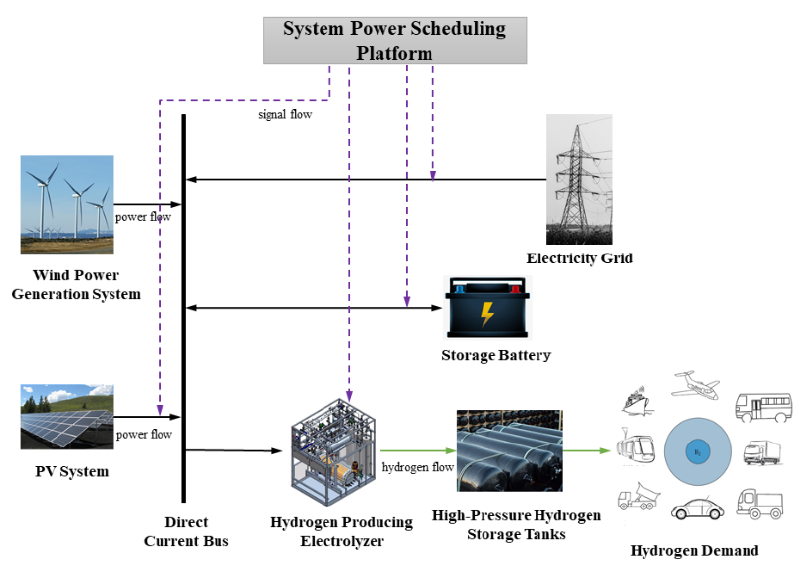
Figure 1. Topological structure of wind and solar power generation coupled with hydrogen energy storage system.